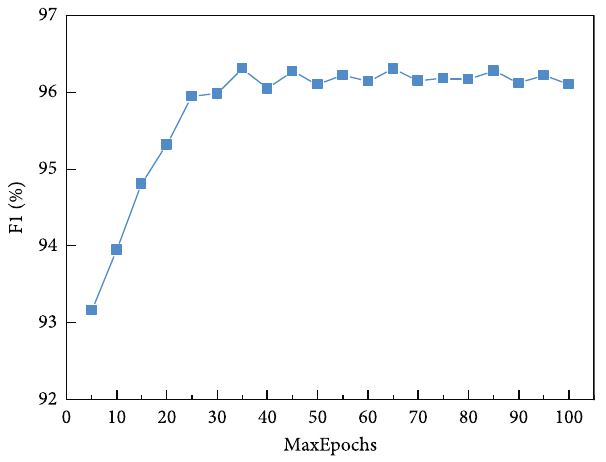
Figure 8: Relationship between MaxEpochs and F1.